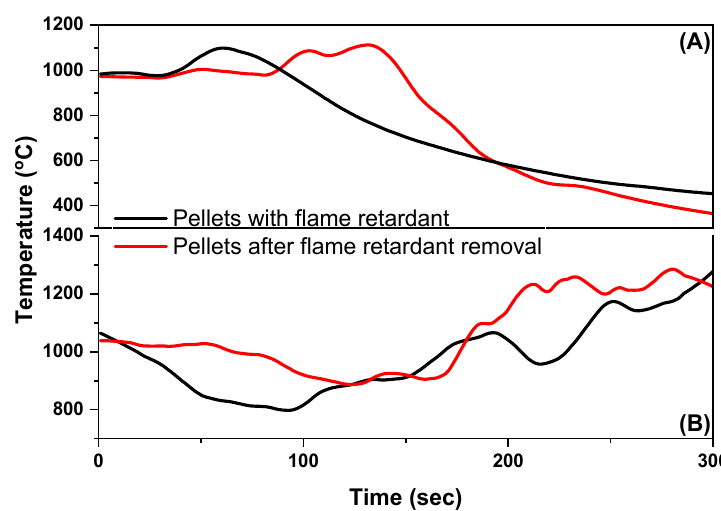
Figure 4. Transitory temperature curve for ( A ) sand (TC-3) and ( B ) fountain (TC-4) of cotton textile pellets with and after flame retardant substrate removal.